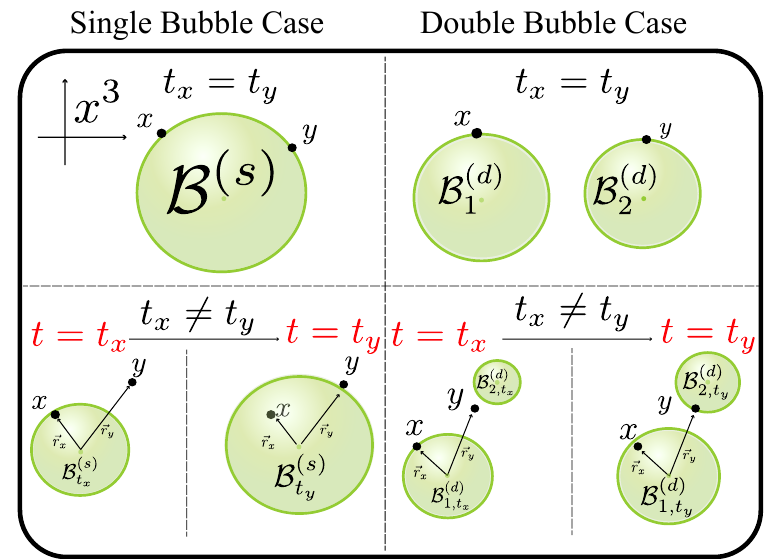
Figure 2 . Sketch of single bubble case and double bubble case. x and y are two spacetime points we are studying, bubble(s) is/are denoted by B , the superscripts ( s ) and ( d ) distinguish the single bubble case and double bubble case. The subscripts t x and t y denote t = t x or t = t y , subscript 1 and 2 denote the first bubble and the second bubble in double bubble case. The left panel corresponds to the single bubble case, and the right panel characterizes the double bubble case. Note that we don’t require the spatial points x and y to stay in the bubble walls at the same time, so they can be in the bubble walls at different time as the lower panel of this figure